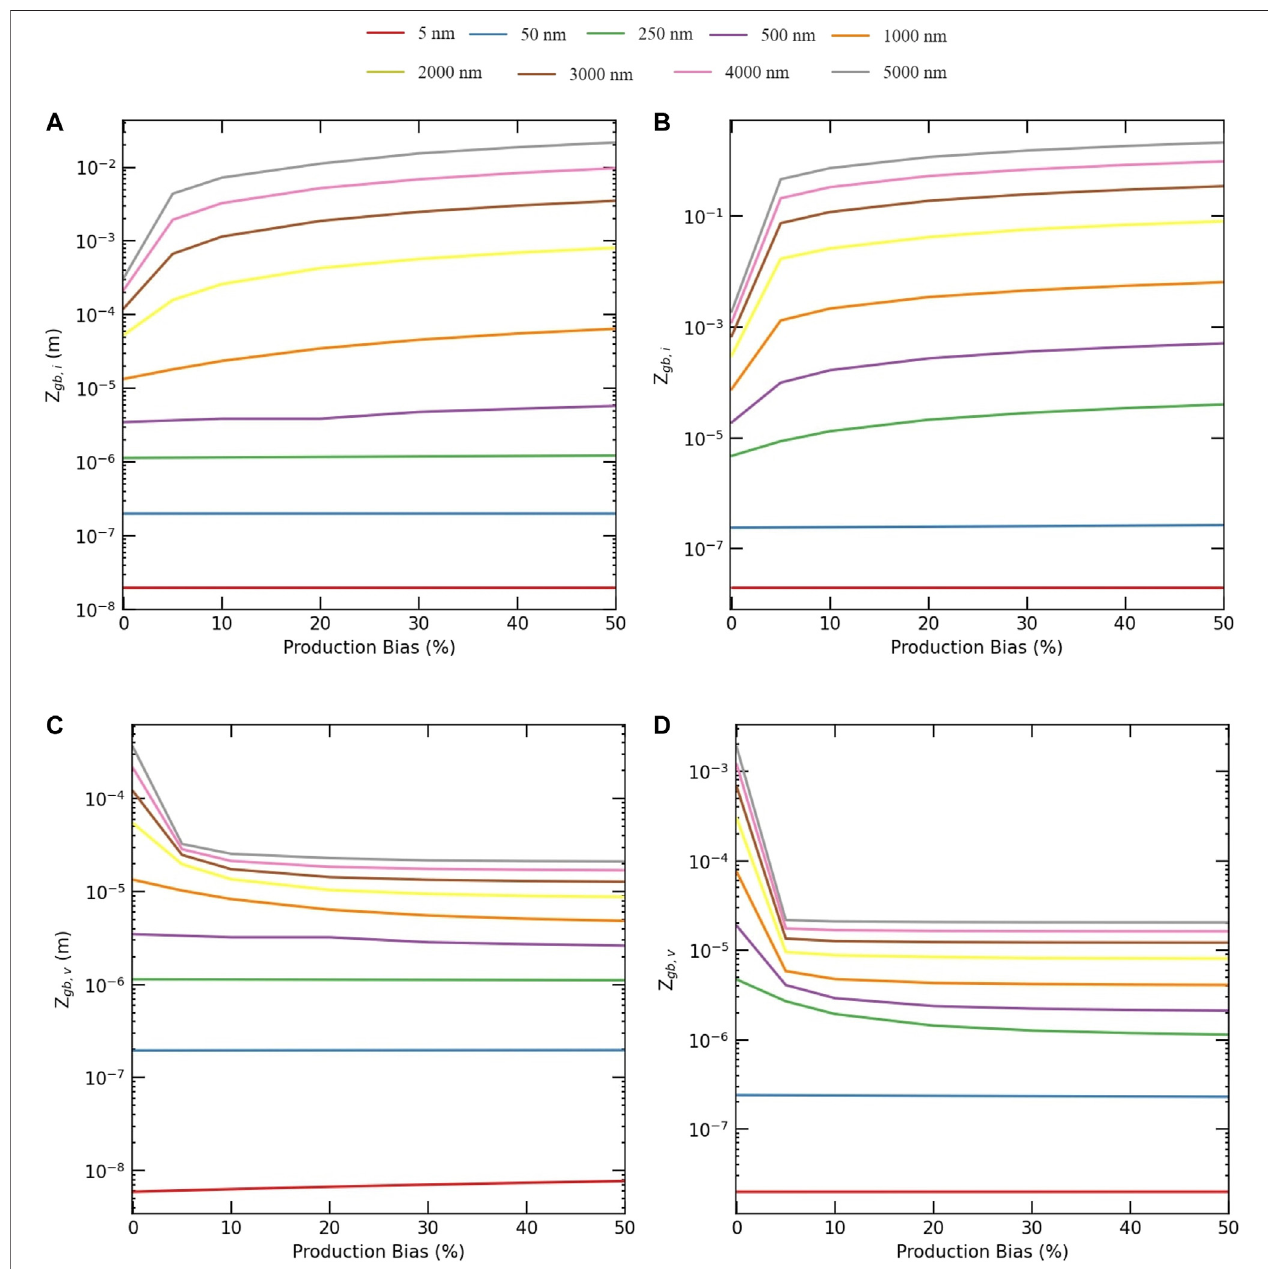
FIGURE10| Change of individual grain boundary sink strengths with production bias and grain size. Upper row : Interstitials, Z gb , i , for (A) low dose rate (1e-6 dpa/s), and (B) high dose rate (1e-3 dpa/s). Lower row : Vacancies, Z gb , v , for (C) low dose rate (1e-6 dpa/s), and (D) high dose rate (1e-3 dpa/s). Below the critical size, the boundary sink strengths for both defects are equal and constant (independent of the value of production bias). However, at and above the critical size, the boundary sink strength for interstitials increases with bias, while it decreases with bias for vacancies.